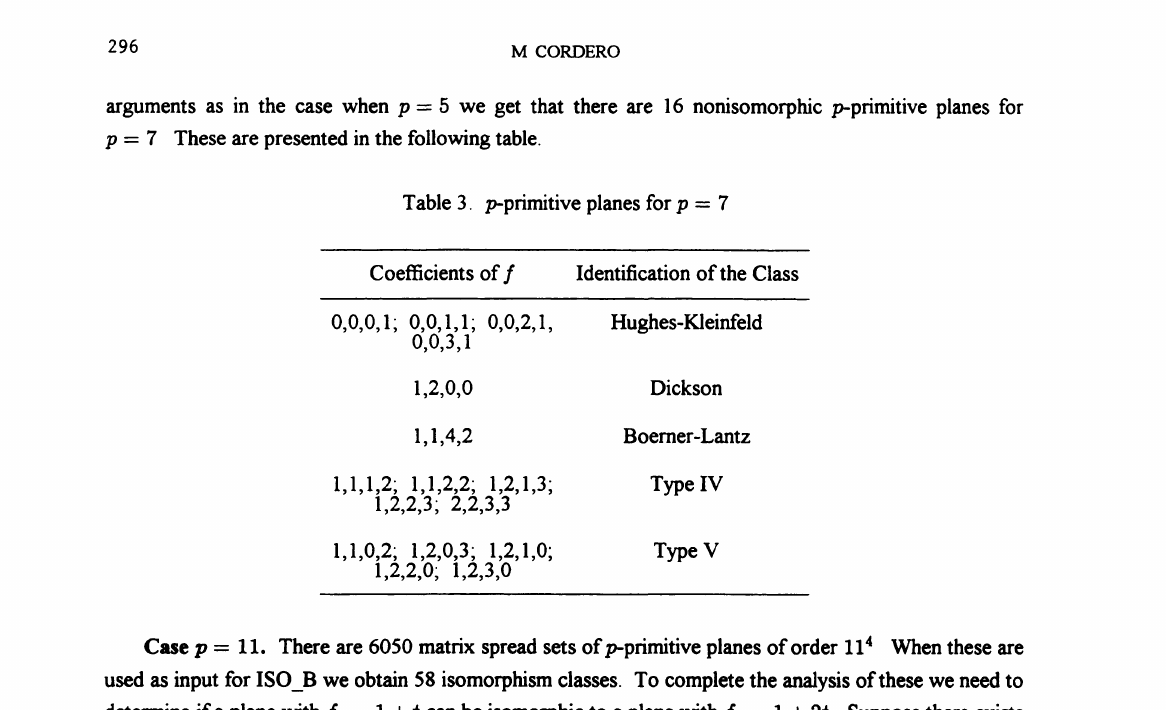
Table 4. p-primitive planes for